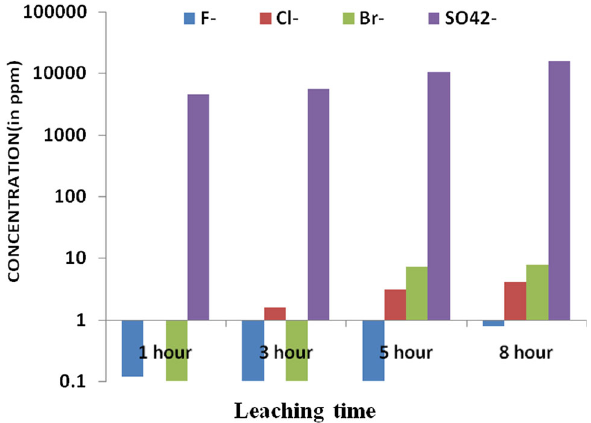
Fig. 19 Change in concentration (in ppm) of anions in aqueous leachates of Ledo coal (LC-20A) with leaching time (in hour) at 65 (cid:3) C